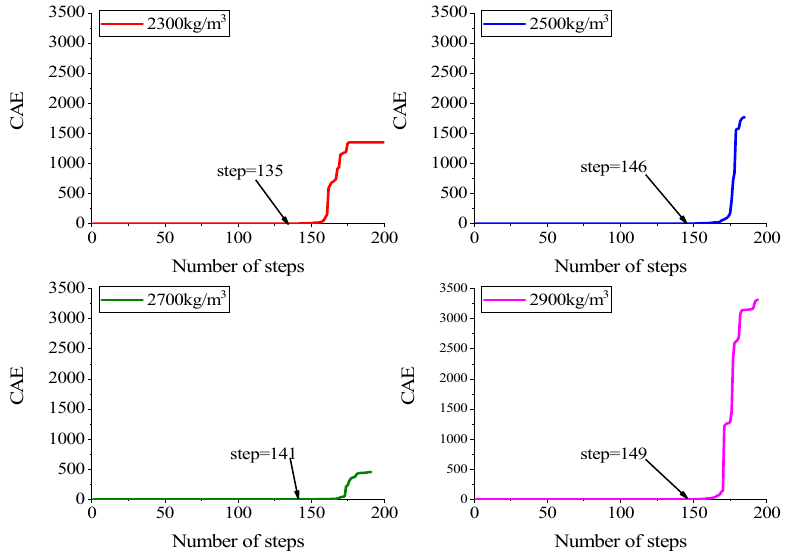
Figure 5. Initiation steps change with overburden pressures by changing the overlying rock densities. CAE is the abbreviation of the Cumulative Acoustic Emission.